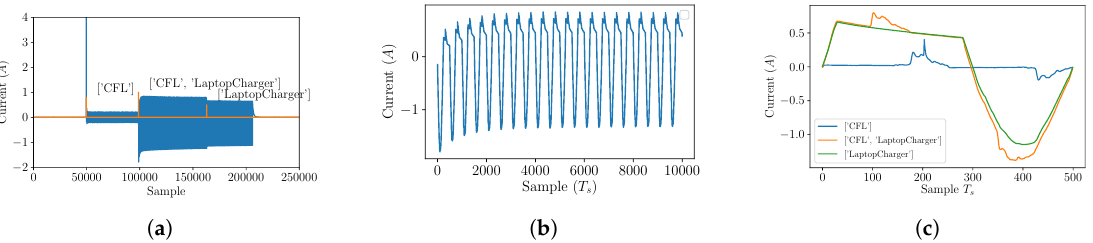
Figure 2. ( a ) Aggregated current signal for different events. ( b ) Twenty cycles of current after an event. ( c ) Extracted activation currents for different events. The activation current of the event at time i is the summation of the activation current for the all running appliances.